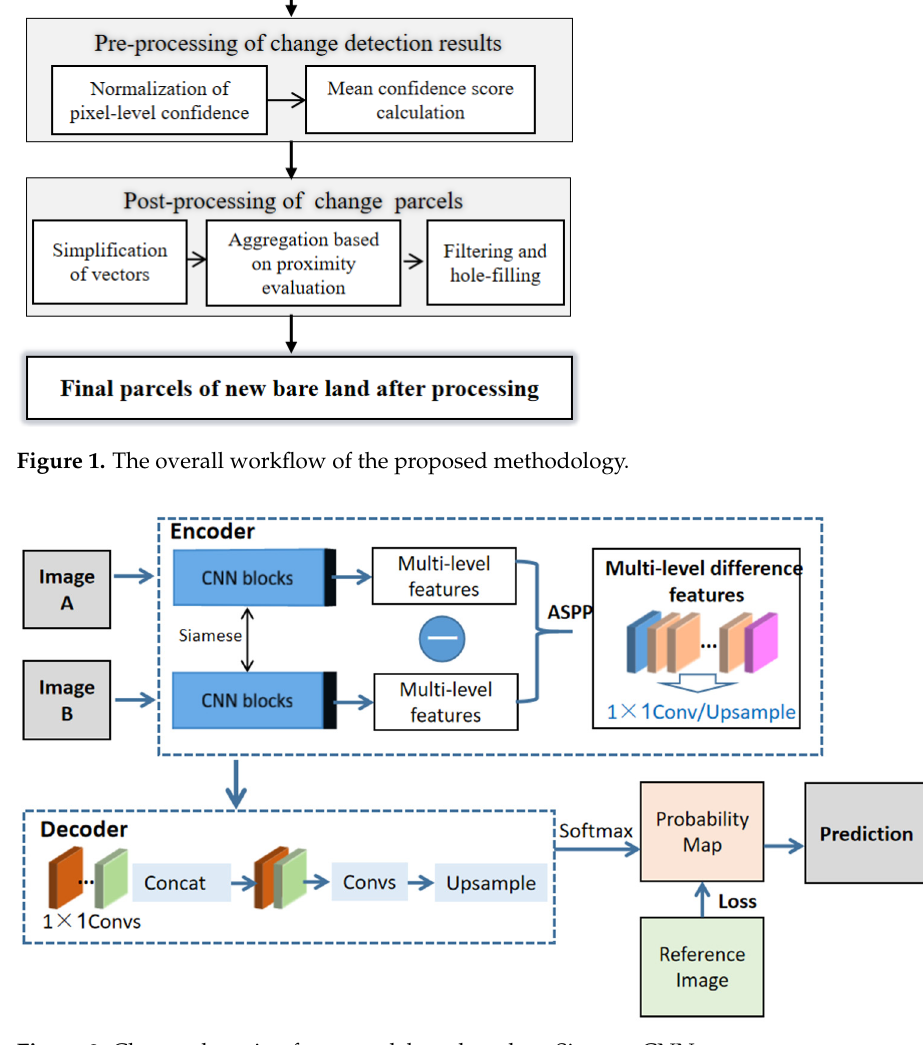
Figure 2. Change detection framework based on deep Siamese